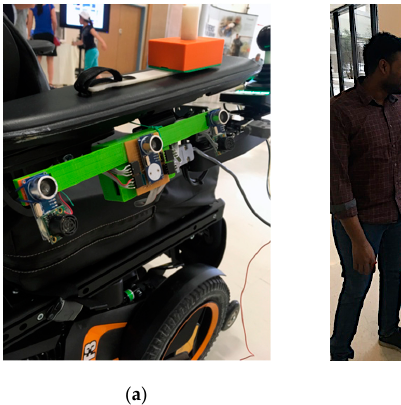
Figure 2. Detection area beside the powered wheelchair for AP identification. Beam patterns converge at the center of where the person is expected to walk.